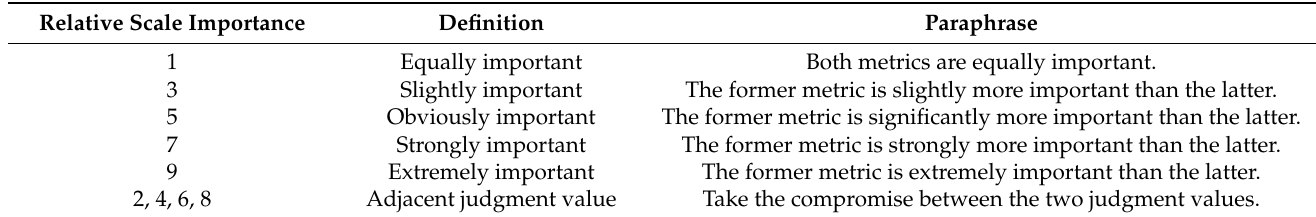
Table A2. 1~9 ratio-scaled